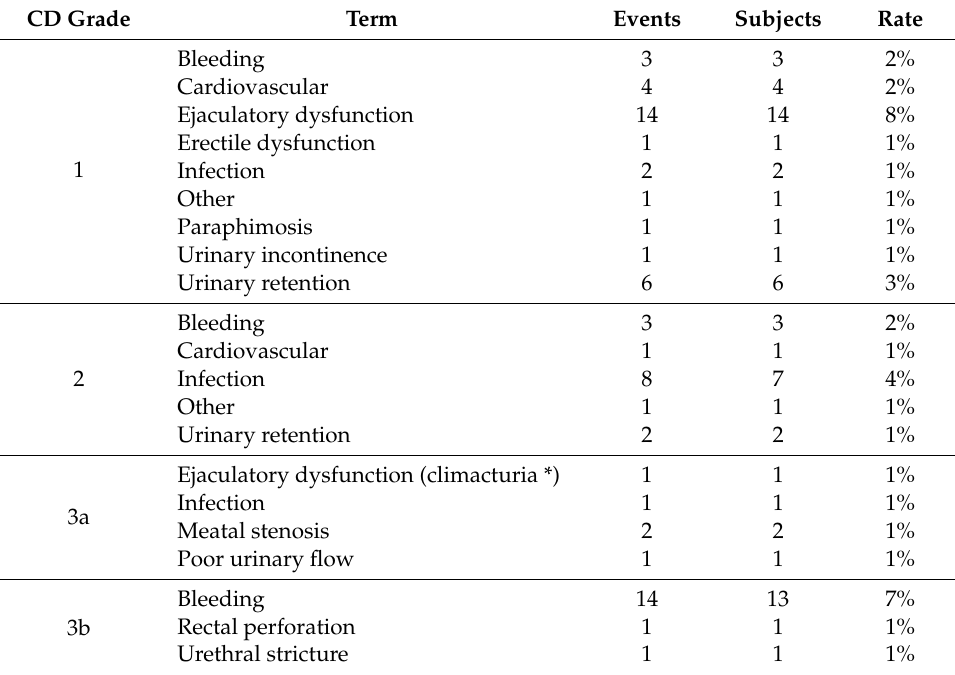
Table 3. Distribution of perioperative complications categorized by Clavien–Dindo